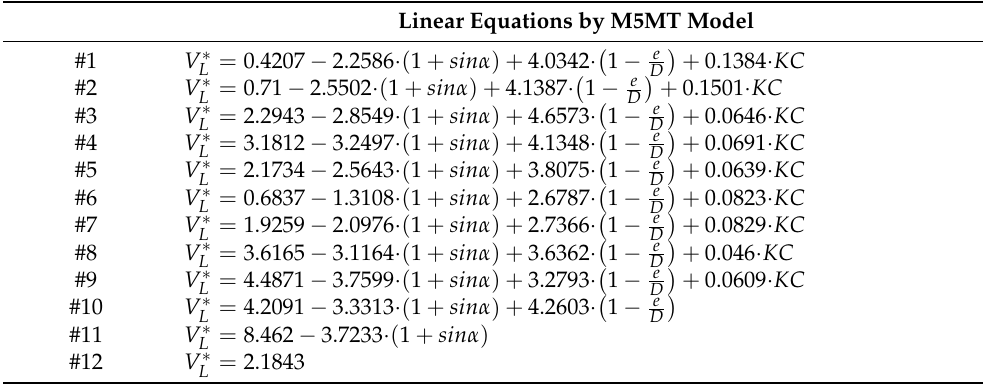
Table A7. Linear equations obtained by M5MT model to predict V ∗